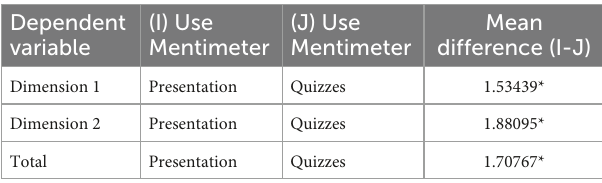
TABLE 14 Results of Scheffe’s post hoc test (based on most commonly used Mentimeter’s tool).